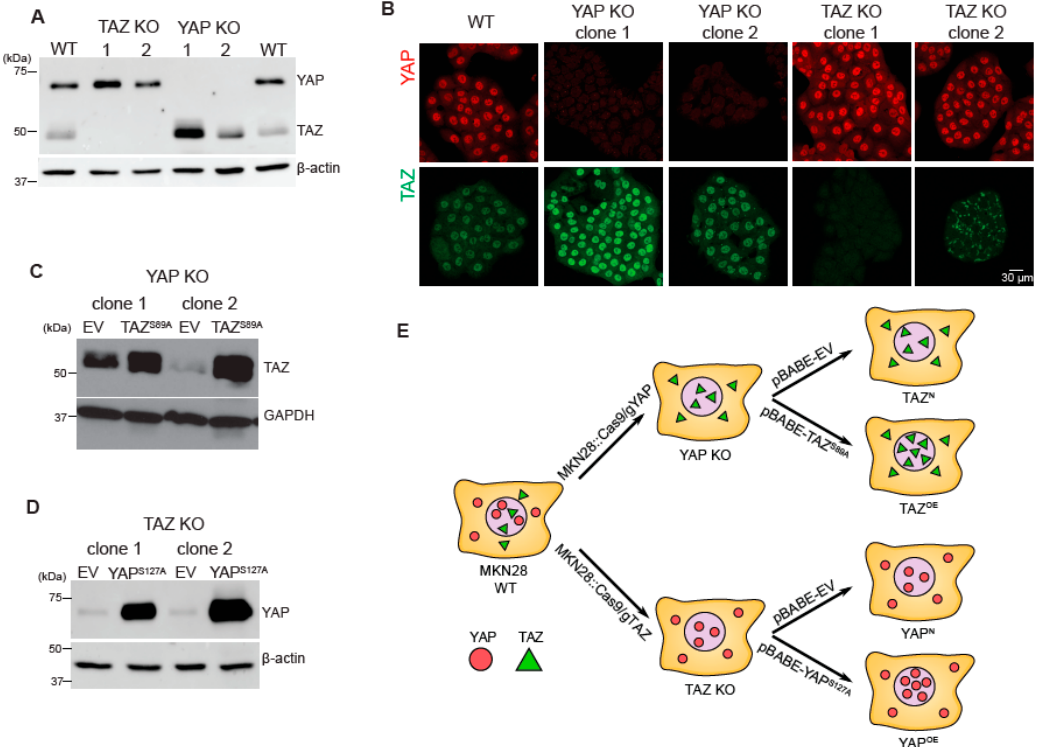
Figure 1. RNA-sequencing (RNA-seq) of the samples generated with gastric cancer MKN28 cells and activated mutants of YAP or TAZ genes. ( A ) Western blot analysis of YAP knockout (KO) and TAZ KO clones generated via the CRISPR/Cas9 system using two independent guide RNA sequences (labelled as 1 and 2) against human YAP and human TAZ. The wild type (WT) sample is shown in the first and last lane. β -actin is used as a loading control. The protein molecular weight size marker (unit: kDa) is depicted along the left of the Western blot images. The uncropped western blot figures in Figure S1. ( B ) Representative immunofluorescence images of YAP and TAZ in WT, two clones of YAP KO and TAZ KO. ( C ) Western blot analysis of YAP KO cells transduced with empty vector (EV, control) or TAZ S89A (overexpression, OE). GAPDH is used as a loading control. ( D ) Western blot analysis of TAZ KO cells transduced with empty vector (EV) or YAP S127A (OE). β -actin is used as a loading control. The uncropped western blot figures in Figure S2. ( E ) A schematic diagram of the samples prepared for RNA-seq.